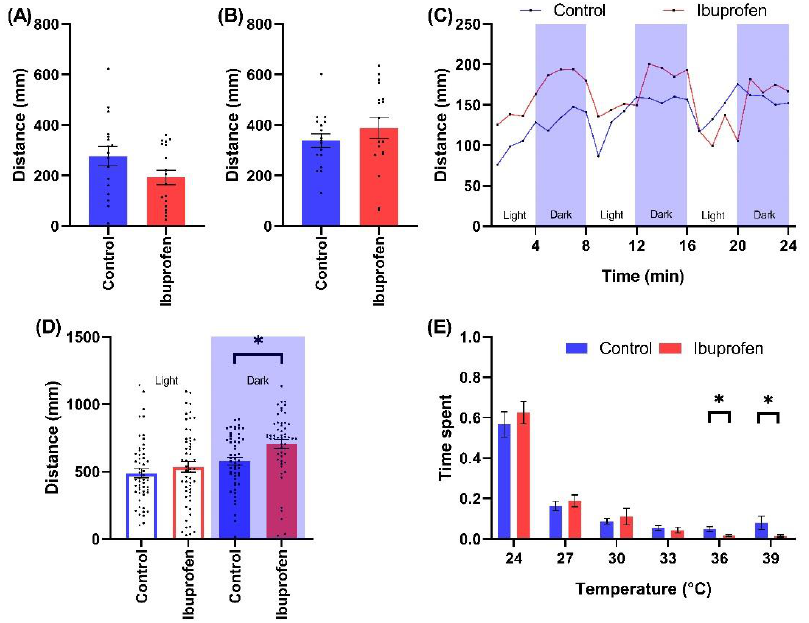
Figure 4. The effects of ibuprofen (9800 ng/L) on wild type zebrafish behaviors throughout the testing battery. The behavioral battery included ( A ) Spontaneous swimming, ( B ) SPR, ( C ) Time resolved LPR, ( D ) LPR cumulated comparison, and ( E ) Thermotaxis assay. Note * 0.05 > p > 0.01.